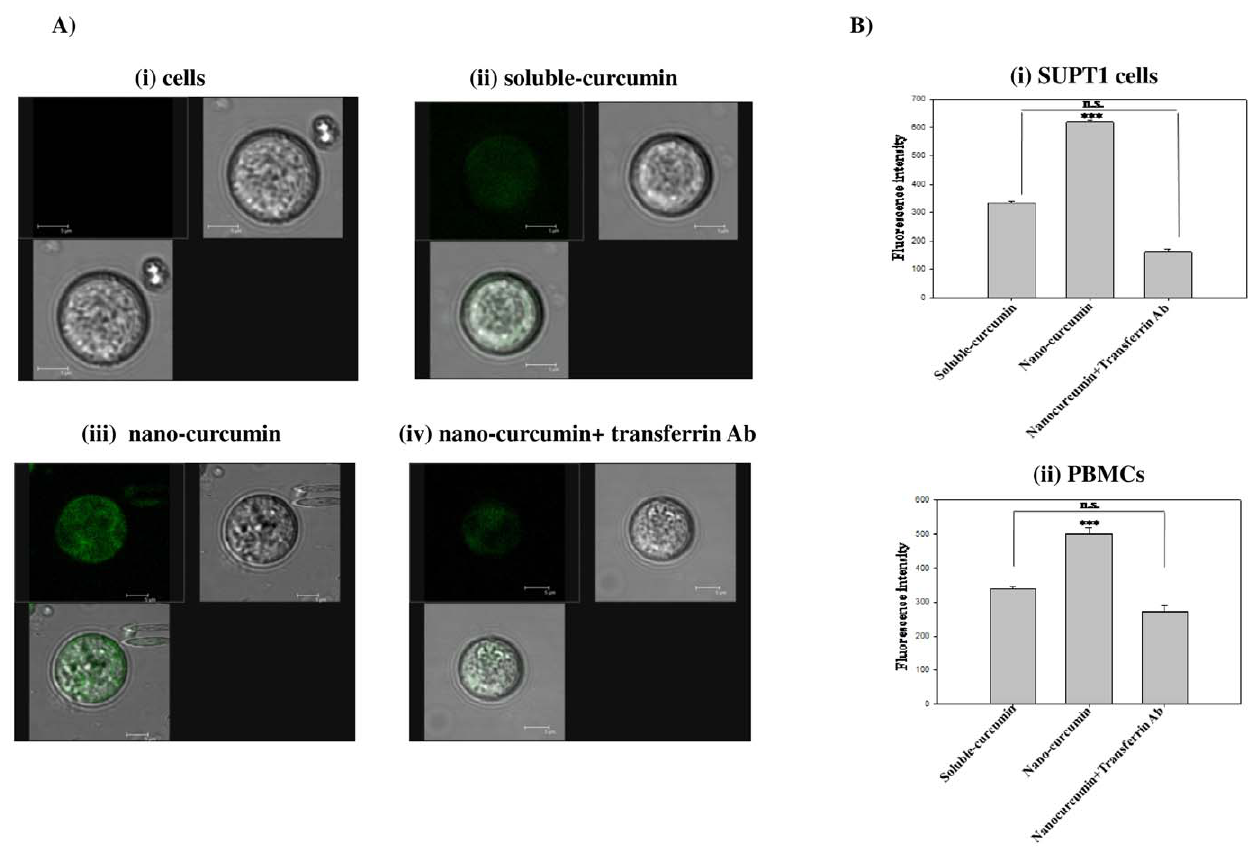
Figure 2. Nanoparticle formulation increases curcumin uptake, which is inhibited by transferrin receptor blockade. A) SUP-T1 cells were incubated for 1 h with curcumin formulations as indicated, then examined by confocal microscopy. (i) Cells without curcumin; (ii) 1 m M sol- curcumin; (iii) 1 m M nano-curcumin; or (iv) 1 m M nano-curcumin in the presence of transferrin receptor antibody (100 ng/ml). Each panel contains three images: fluorescence, bright field and merged. B) SUP-T1 cells (i) or stimulated PBMCs (ii) were incubated for 1 h with curcumin formulations, after which intrinsic fluorescence of intracellular curcumin was determined quantitatively by fluorometric analysis. Cells were treated with 5 m M sol- curcumin, 5 m M nano-curcumin, or 5 m M nano-curcumin in the presence of antibodies to the transferrin receptor (TrR-Ab; 100 ng/ml). All the values are normalized to that obtained from SUPT1 cells. Error bars indicate standard deviation (SD). ***, P # 0.001 compared to sol-curcumin; n.s.: non-